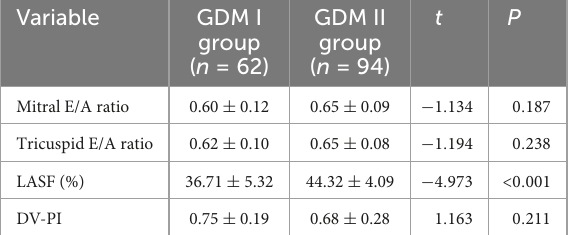
TABLE 3 Comparison of general clinical data between GDM I group and GDM II group.